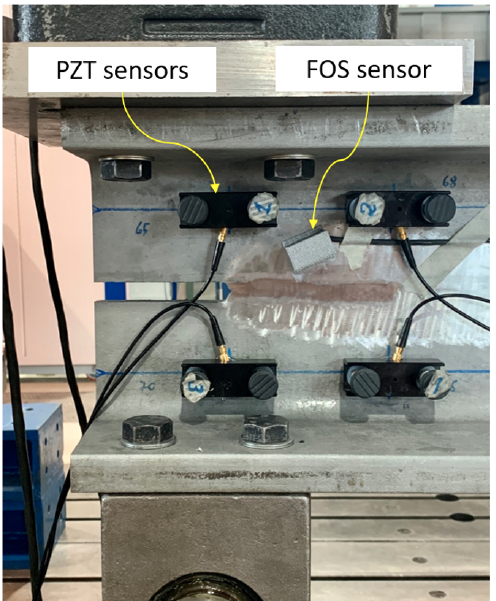
Figure 9. Layout for acoustic emission sensing by PZT sensors and the proposed FOS.